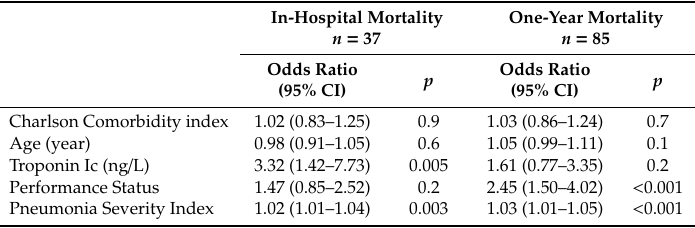
Table 4. Multivariate analysis of factors associated with in-hospital and one-year mortality after acute pneumonia in older inpatients ( n (%) or median (interquartile range)).